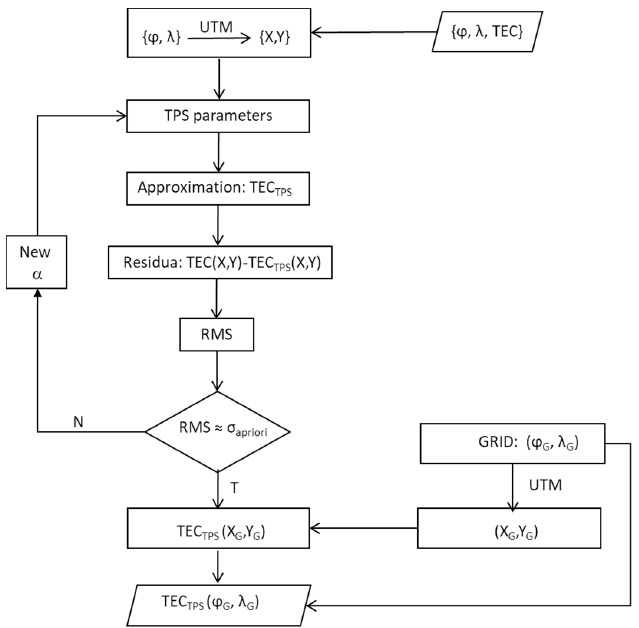
Figure 1. Schematic diagram of vertical total electron content (vTEC) modelling by thin plate splines (TPS).